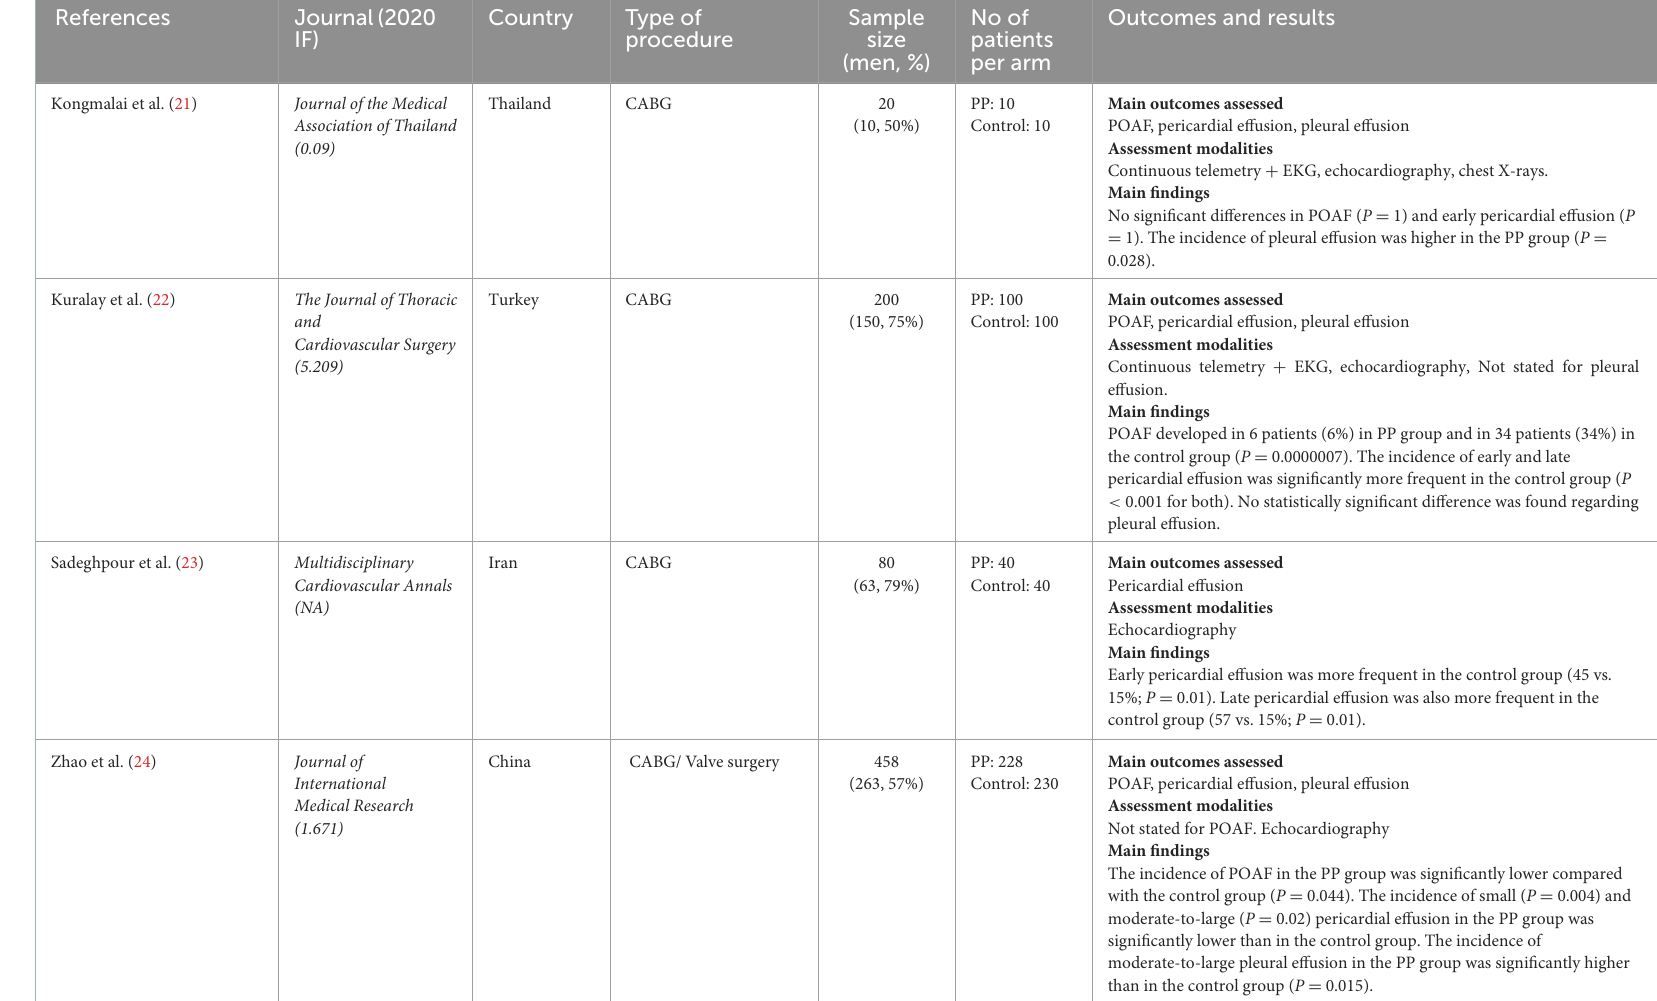
Main outcomes assessed POAF, pericardial effusion, pleural effusion Assessmentmodalities Not stated for POAF. Echocardiography Main findings The incidence of POAF in the PP group was significantly lower compared with the control group ( P = 0.044). The incidence of small ( P = 0.004) and moderate-to-large ( P = 0.02) pericardial effusion in the PP group was significantly lower than in the control group. The incidence of moderate-to-large pleural effusion in the PP group was significantly higher than in the control group ( P =